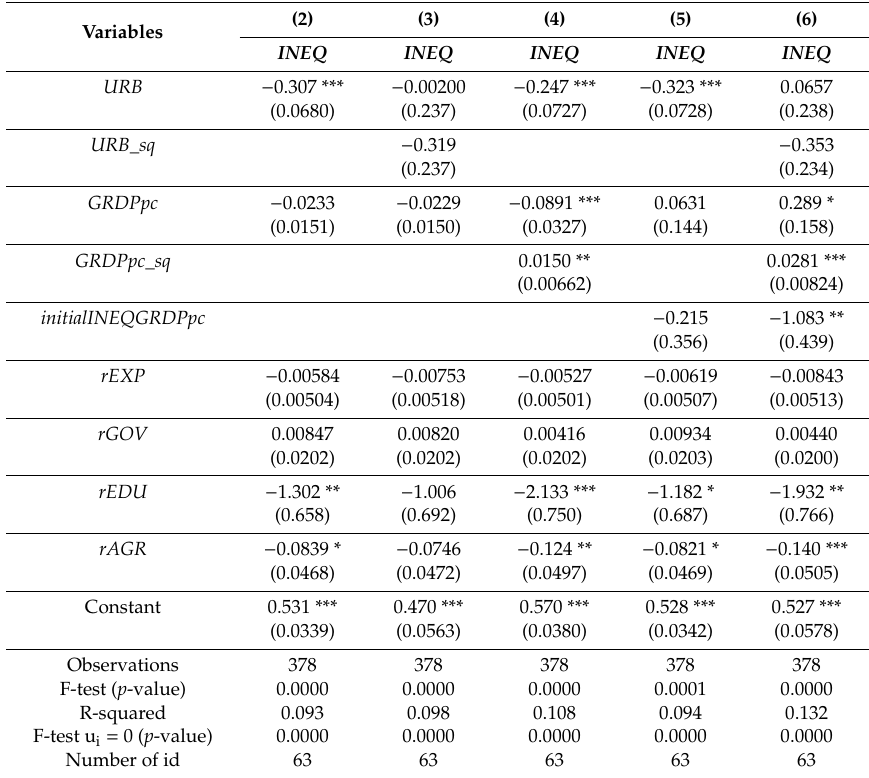
Table 5. Results of fixed e ff ects